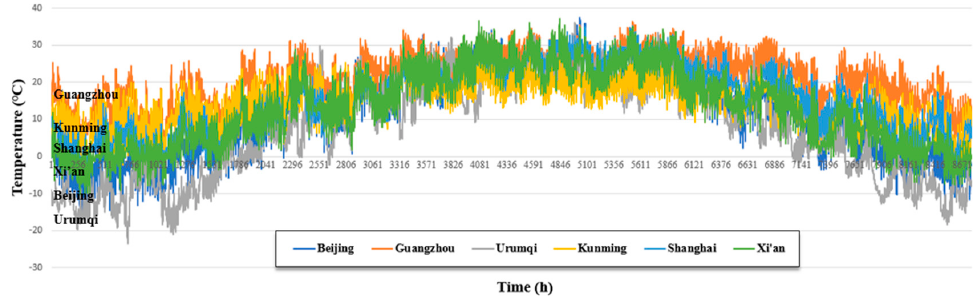
Figure 9. The comparison of outdoor temperatures of selected cities.